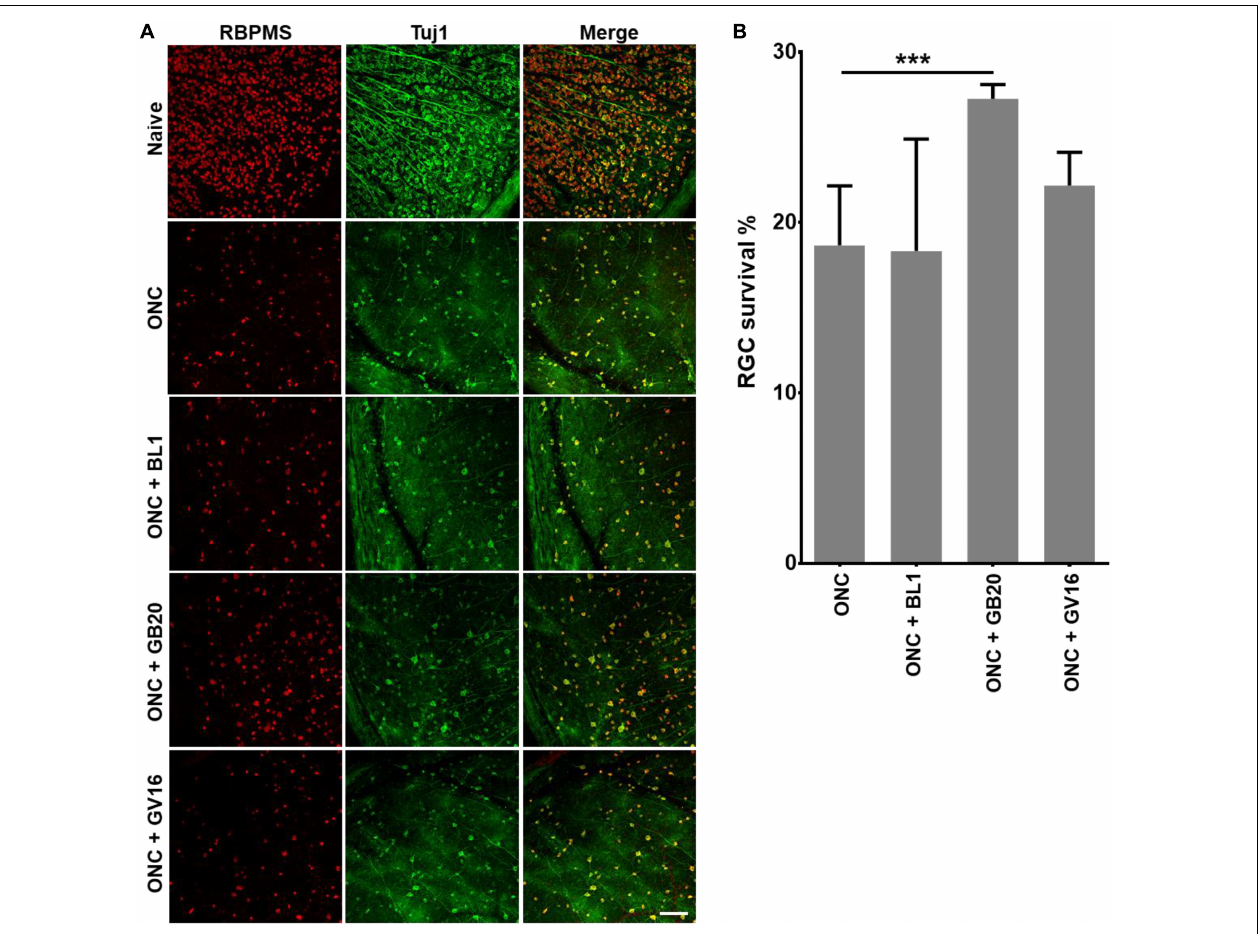
FIGURE 6 | Promotion of RGC survival by acupuncture treatment. (A) Confocal images showing the co-staining of RGC with antibodies of RBMPS (RGC specific marker) and Tuj1 (neuron specific marker). (B) Statistical analysis of survival RGC percentage relative to intact naïve retina. Data are represented as means ± SEM; n = 5; ∗∗∗ p <